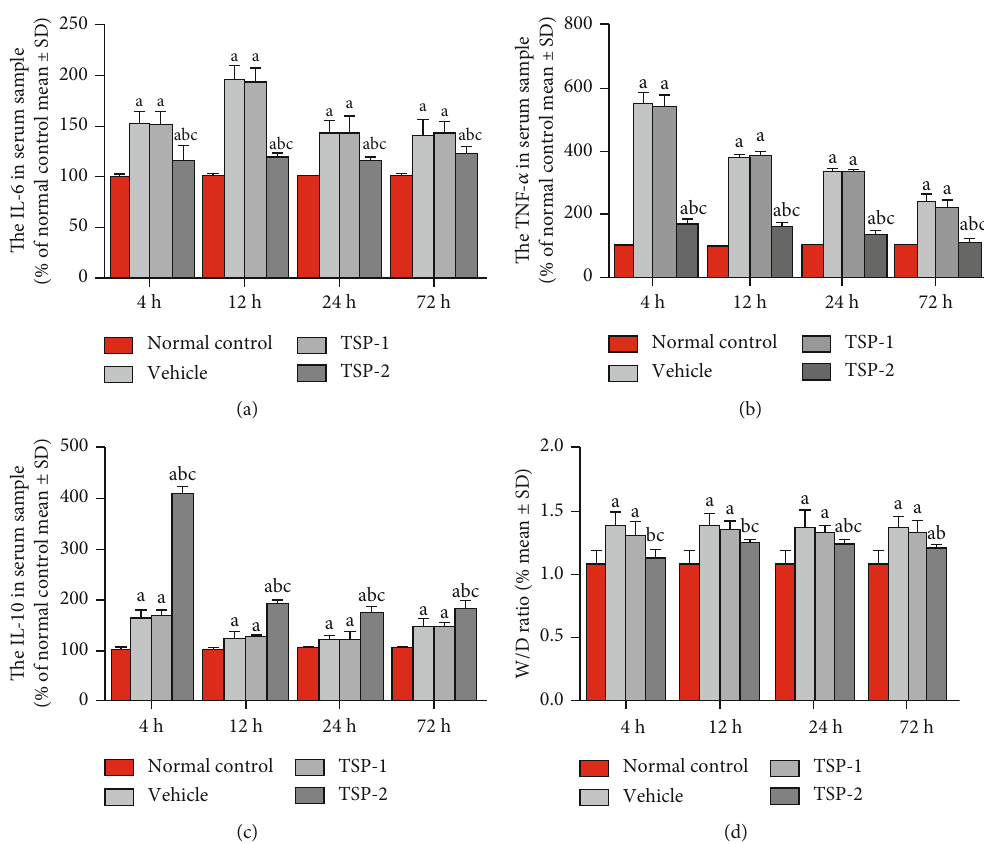
Figure 4: ELISA analyses of in fl ammatory cytokines in mouse serum and assessment of lung W / D ratios. (a – c) Bar graphs representing in fl ammatory cytokines IL-6 (a), TNF- α (b), and IL-10 (c) in serum from the normal, vehicle, TSP-1, and TSP-2 groups, using ELISA. (d) Comparison of lung W / D ratio among the four groups. (a – c) The percentage of expression level of each group/normal control is shown as mean ± SD . (d) The lung W / D ratio of each group is shown as mean ± SD . P value of < 0.05 represents signi fi cant di ff erence. a P < 0 : 05 compared with normal control; b P < 0 : 05 compared with the vehicle group; c P < 0 : 05 compared with the TSP-1 transfected group ( n = 5 per